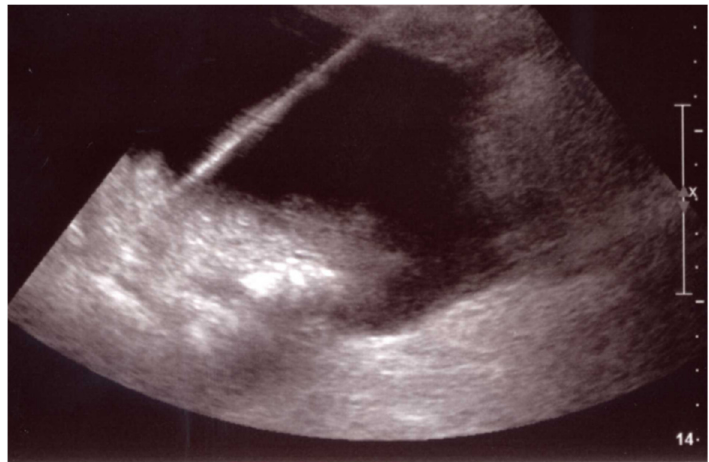
Figure 1. Fluid collection US-guided drainage. A percutaneous drainage can be easily placed in real time under US guidance in a fluid collection post-pancreatic surgery if it is superficially located and/or ultrasonically visible.